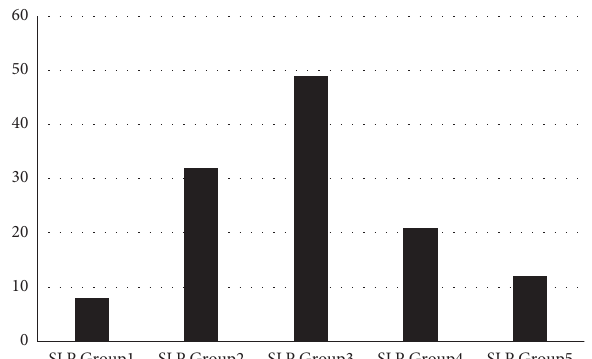
Figure 7: Number of zones in each SLP